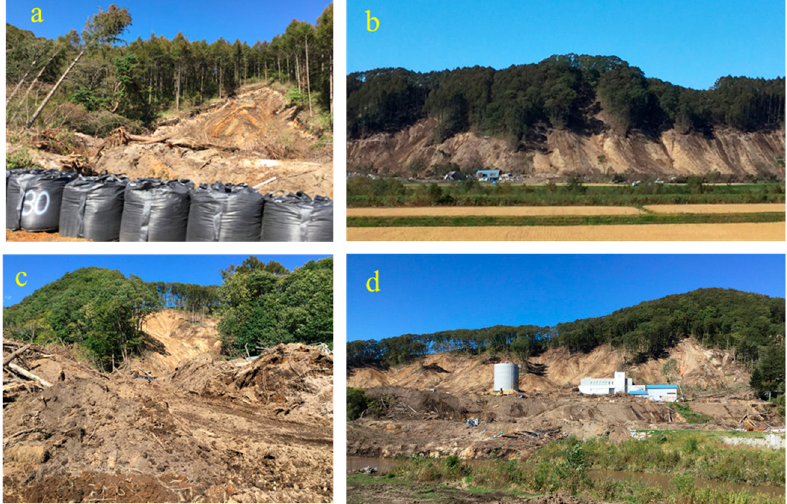
Figure 2. Field photographs of landslide areas in Atsuma town: ( a ) landslide along highway; ( b ) landslide hit houses in Yoshino district; ( c ) and ( d ) landslide hit water facility in Tomisato district. The approximate locations of those photos are indicated in Figure 1( b ) as green circles.